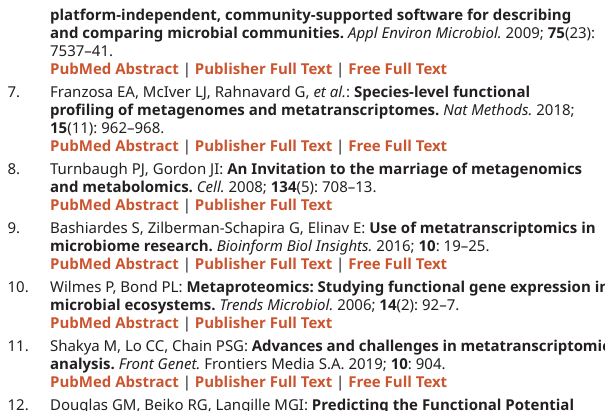
Supplementary Figure S3: Uniref50 Gene Family output with abundance - Supplementary Figure S4: Conversion of Uniref 50 values to GO